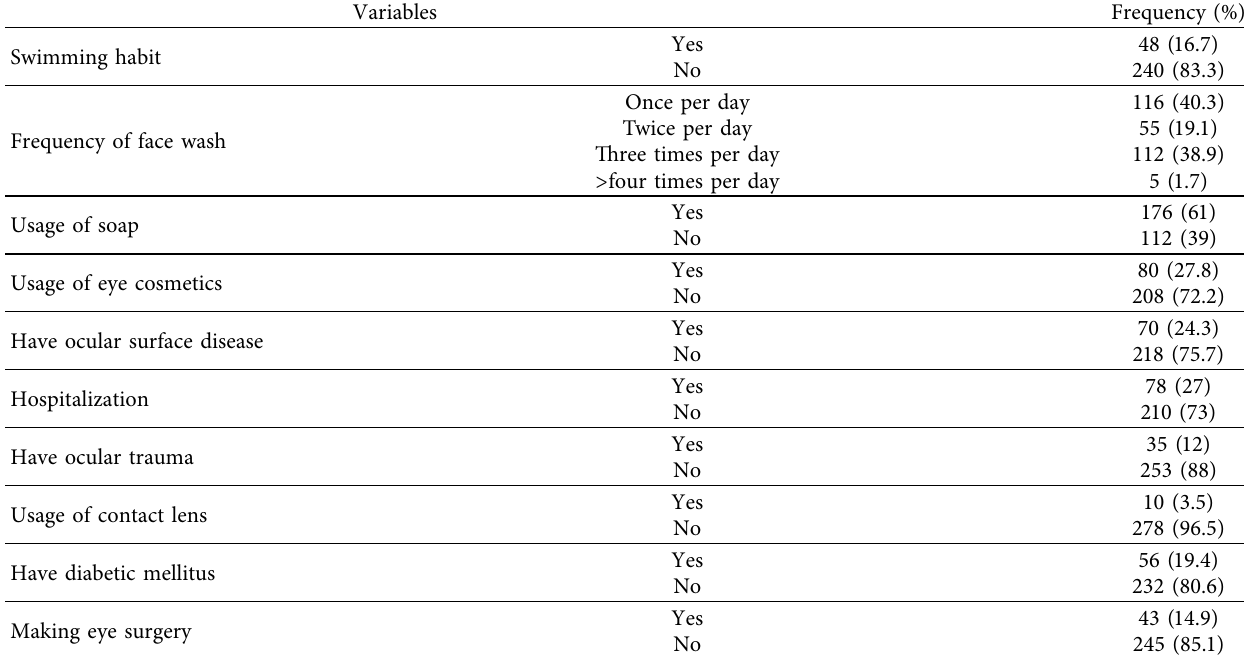
Table 2: Personal and clinical related factors of patients attending at Karamara hospital, Jigjiga, eastern Ethiopia, 2020.